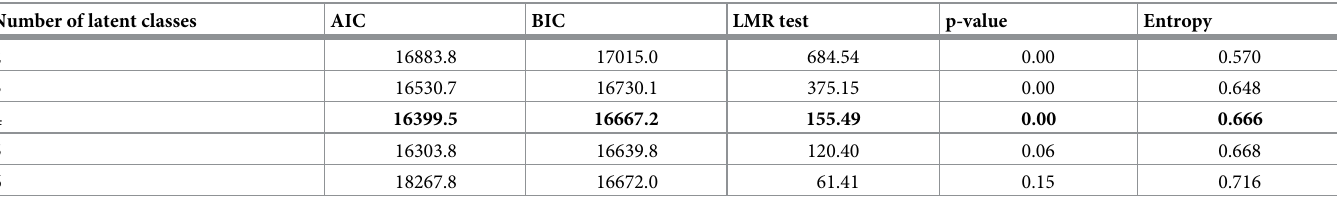
Table 2. Latent Class Analysis—Fit statistics.